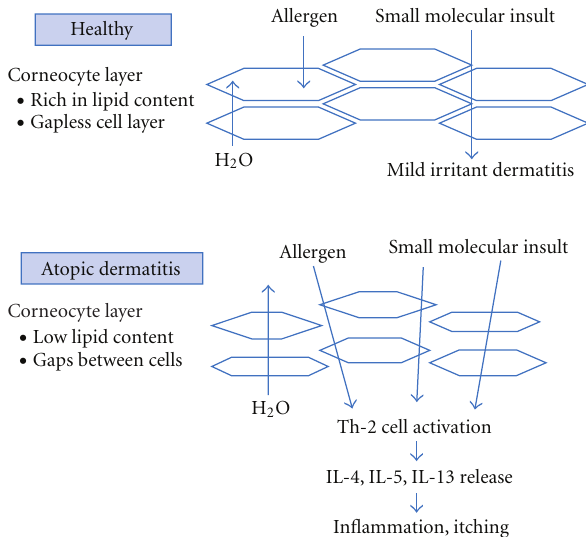
Figure 2: Skin of individuals with atopic dermatitis is fundamen- tally di ff erent compared with healthy